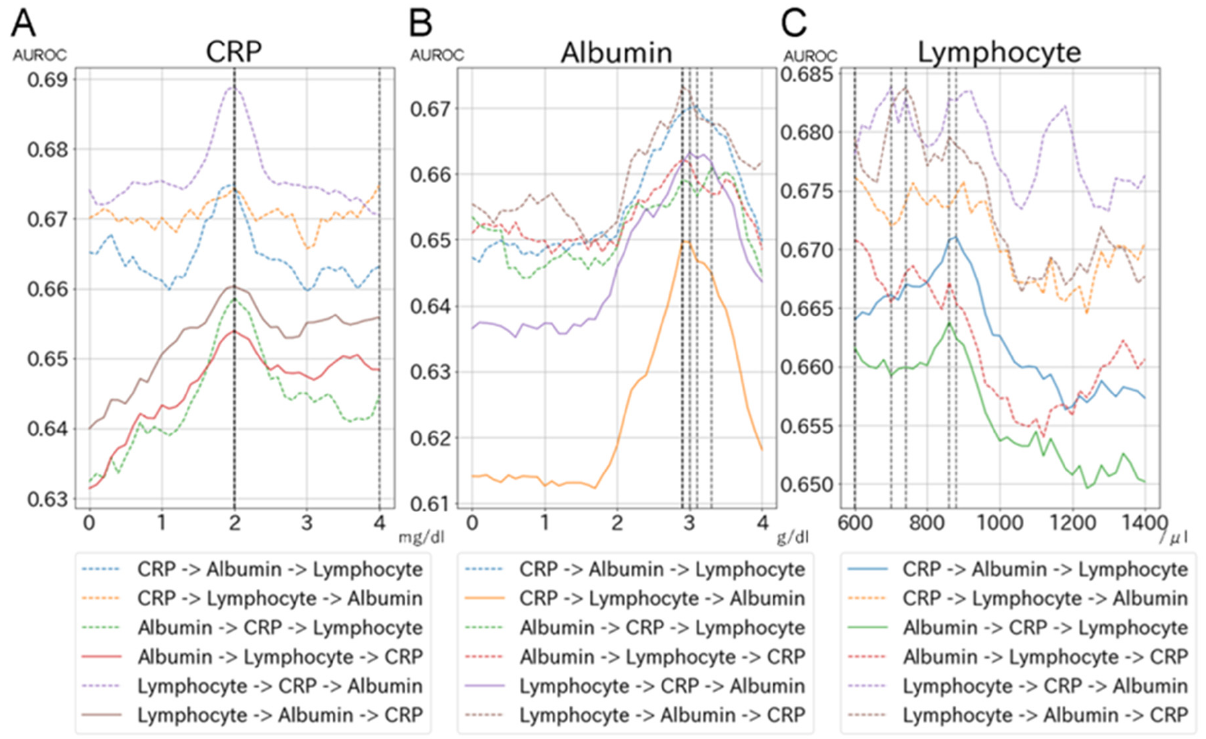
Figure 2. Changes in AUROC for each combination of the order of biomarkers in the XGBoost model. Figures show the relationship between each biomarker and the AUROC for the primary outcome using the XGBoost model: panel ( A ) indicates the change in the AUROC of CRP when the cut-off values of the other two biomarkers were fixed. Similarly, panels ( B , C ) indicate changes in the AUROCs of albumin and lymphocyte count when the cut-off values of the other two biomarkers were fixed. Each panel contains the results of six combinations of the order of biomarkers. Abbreviations: AUROC, area under the receiver operating characteristic; CRP, C reactive